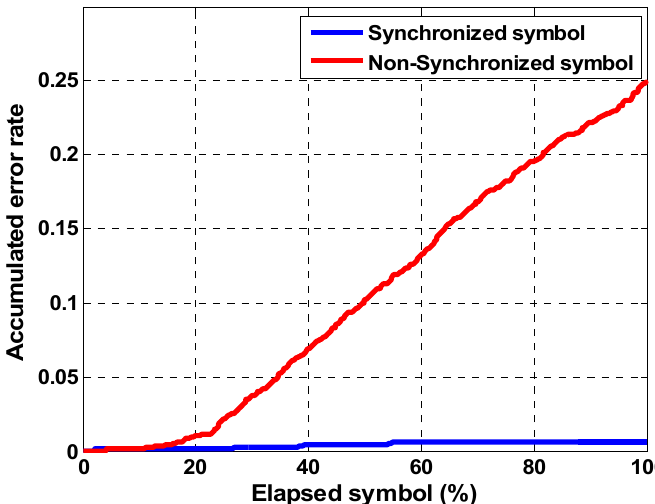
Figure 18. Synchronization performance.